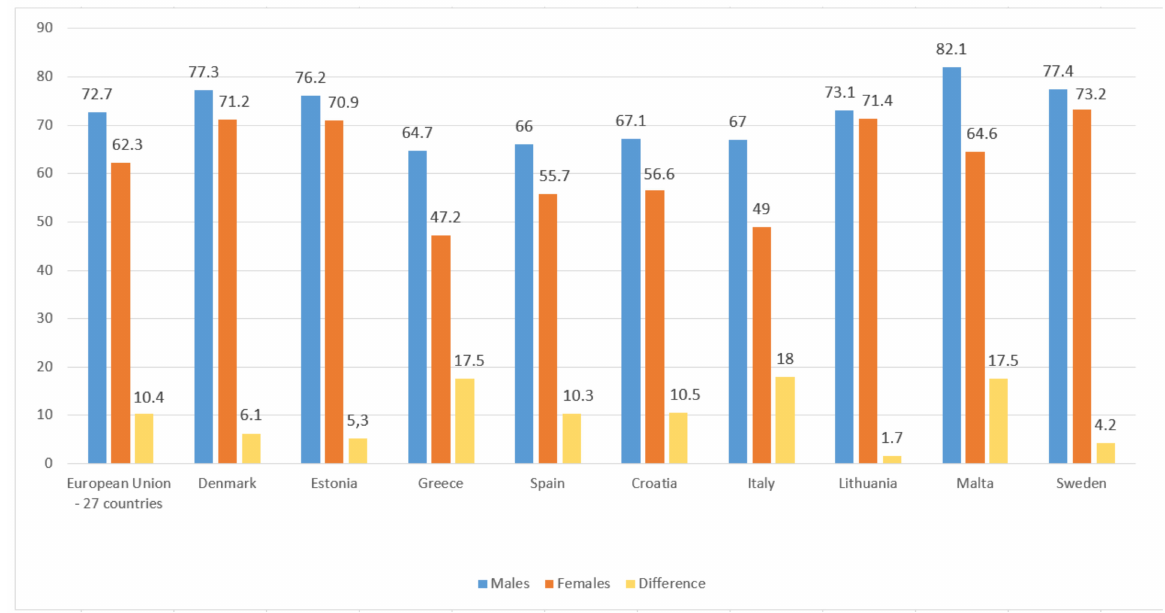
Figure 2. Male and female employment rate, in percentage (first and second quarter of 2020). Source: Own elaboration from data of Eurostar